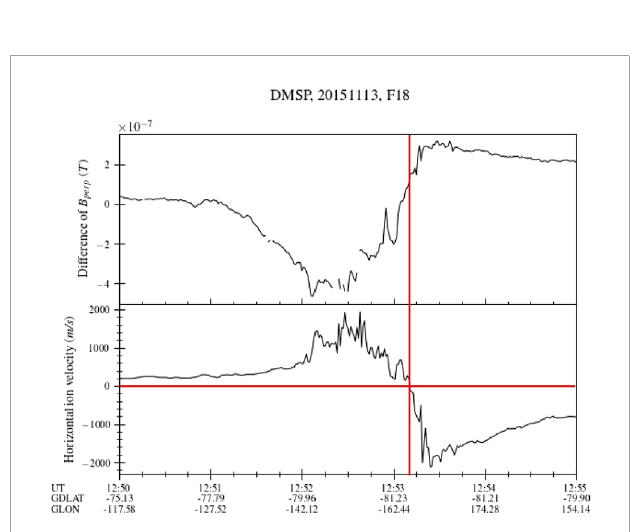
FIGURE 4 F18 observations: difference of B perp and horizontal ion drift velocities. After the ion velocities turn negative shortly after 12:53 UT, marking the convection reversal boundary, we see some magnetic field perturbations, indicative of current flowing on open field lines. F18 is here moving poleward. (Data provided at http://cedar.openmadrigal.org/